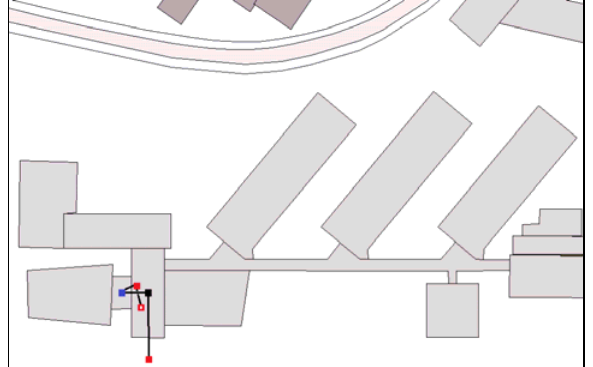
Figure 3. Academic staff offices path.